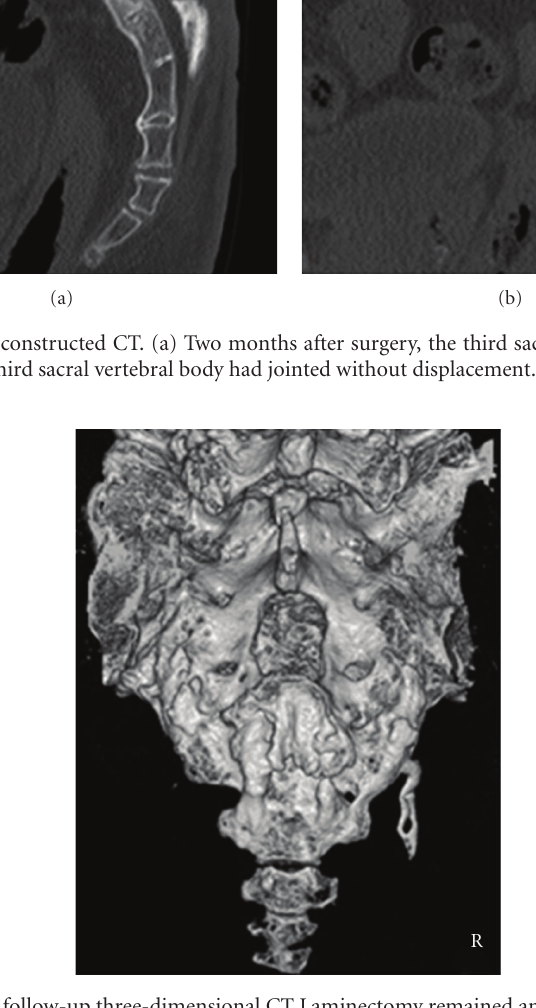
Figure 6: One-year postoperative follow-up three-dimensional CT Laminectomy remained and fracture lines in zone II